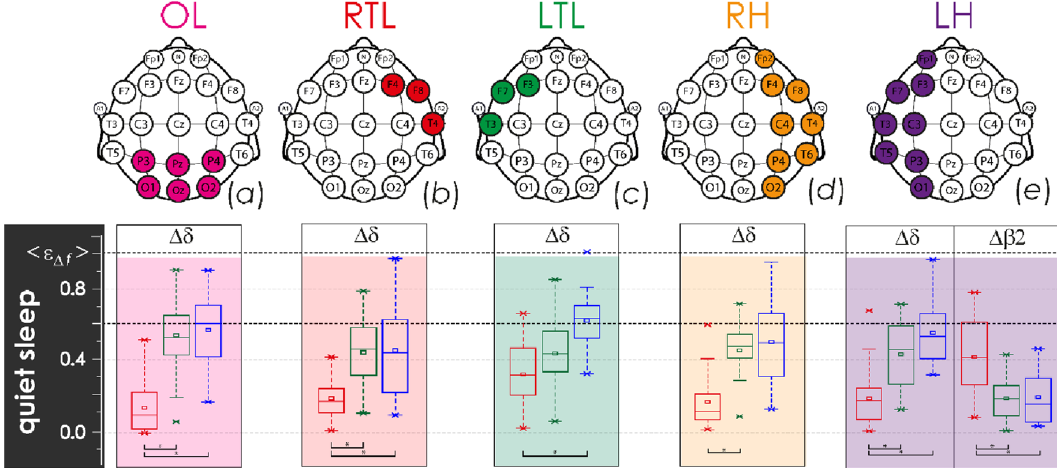
Figure 1. Distributions of the integral averages of relative CWT amplitudes, (cid:31) ε (cid:31) f (cid:30) QS , based on EEG monitoring in newborn groups I and II for the various lobes of the brain, calculated under the physiological state of quiet sleep (QS): ( a ) diagrams for the occipital lobe (OL); ( b ) diagrams for the right temporal lobe (RTL); ( c ) diagrams for the left temporal lobe (LTL); ( d ) diagrams for the right hemisphere (RH); ( e ) diagrams for the left hemisphere (LH). The localization of EEG channels on the scalp for each brain lobe is shown above. Red color indicates estimates for group II (EEG monitoring event GA34–37 10d ), green and blue colors code the estimates of the first and second monitoring events in group I, GA38–41 8h and GA38–41 10d , respectively. The diagrams depict the following statistical characteristics of numerical indicators: the first and the third quartiles (25–75%, inside the box), the median and the mean (transverse line and point inside the box, respectively), 1.5 interquartile ranges (shown by whiskers), and outliers represented by asterisks. At the bottom, underlining with asterisks highlights the pairs of values meeting the Mann–Whitney test with p <